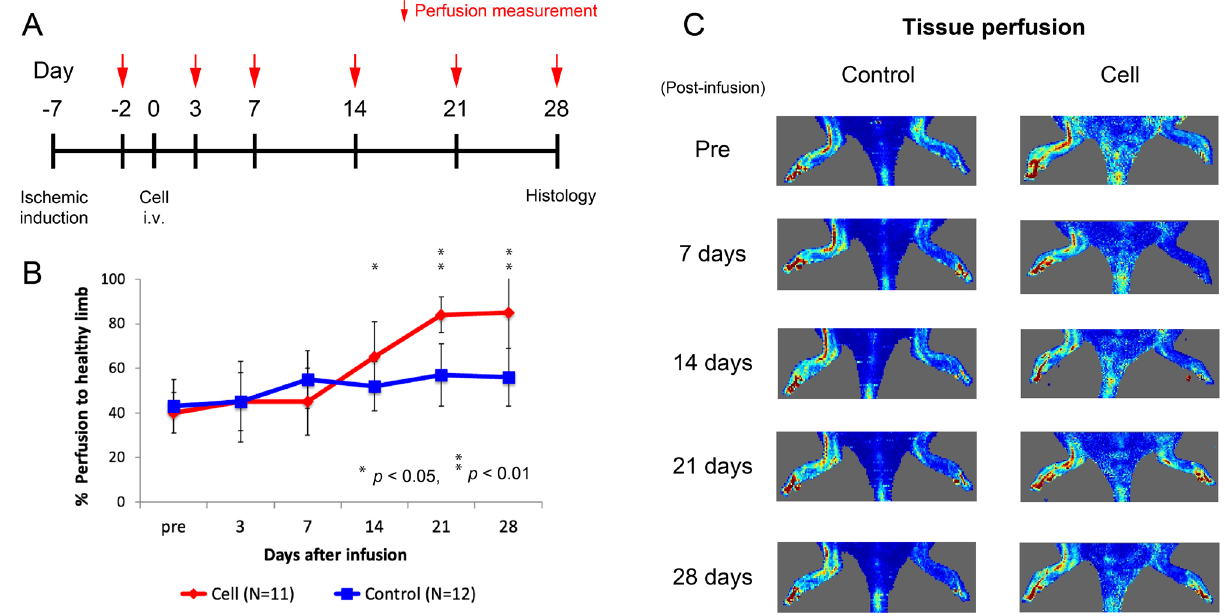
Figure 1. Tissue perfusion determined with laser Doppler. (A) Study timeline. (B) Ischemic hindlimb perfusion measurements after cell infusion. (C) Representative images of tissue perfusion in control and cell infusion groups. * p < 0.05, ** p <